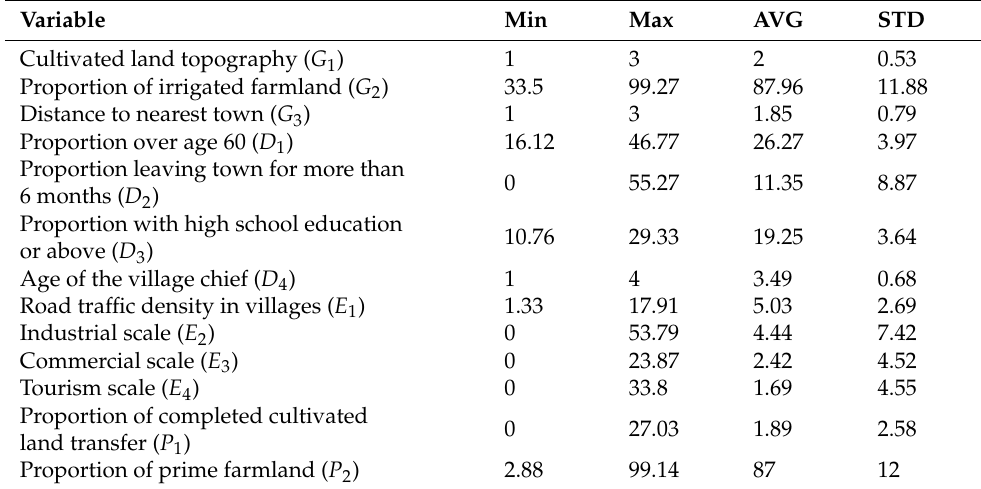
Table 2. Statistical results of independent variables.